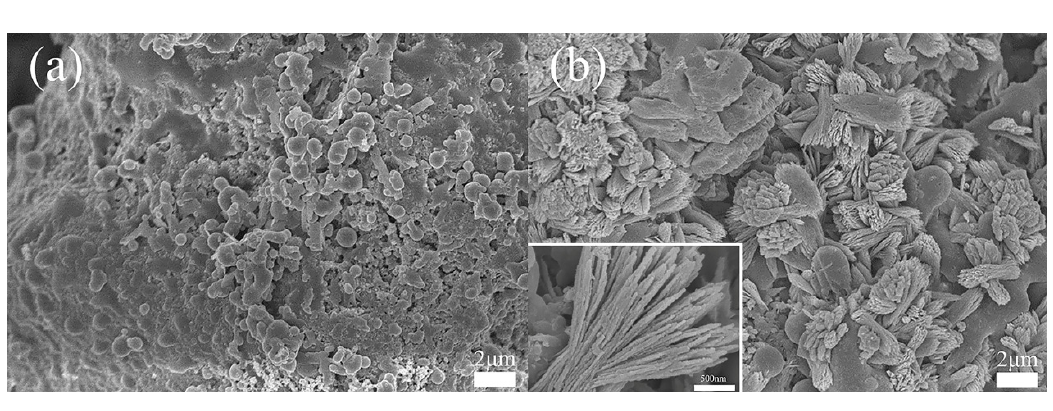
Figure 3. SEM images of ( a ) CaSiO 3 /ABS/TPU ( b ) Ca-MOF/ABS/TPU.